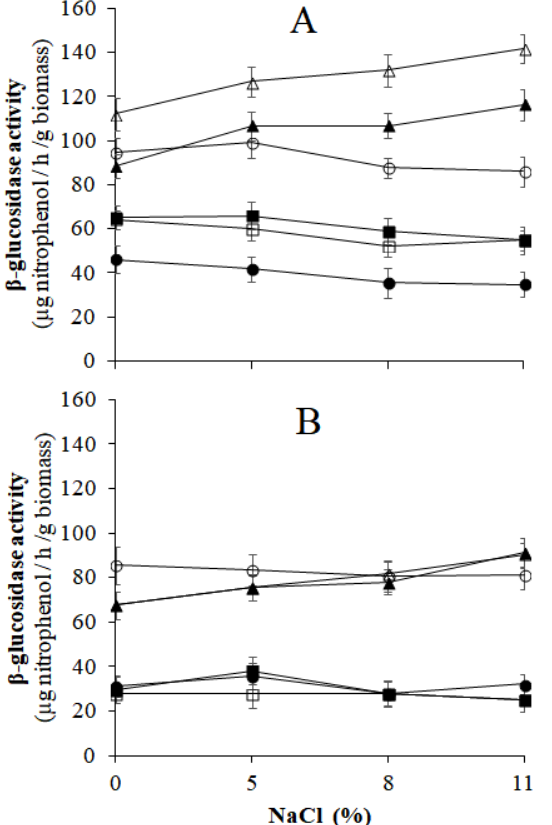
Figure 6. β‐ glucosidase activity of oleuropeinolytic yeast strains grown under aerobic ( A ) and slightly pressurized CO 2 ( B ) conditions, evaluated in the presence of NaCl. ( , S.